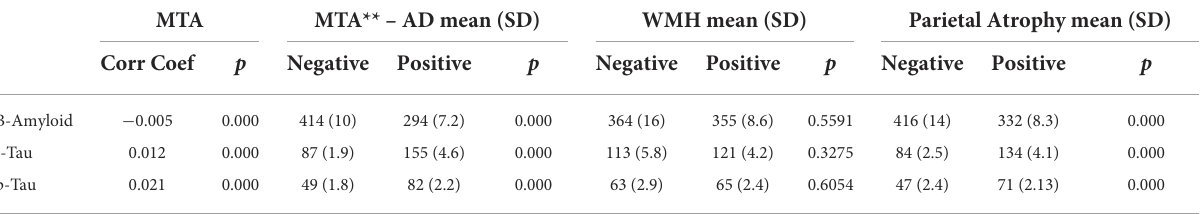
TABLE 3 Correlation between MRI visual rating scale scores and Alzheimer’s disease CSF